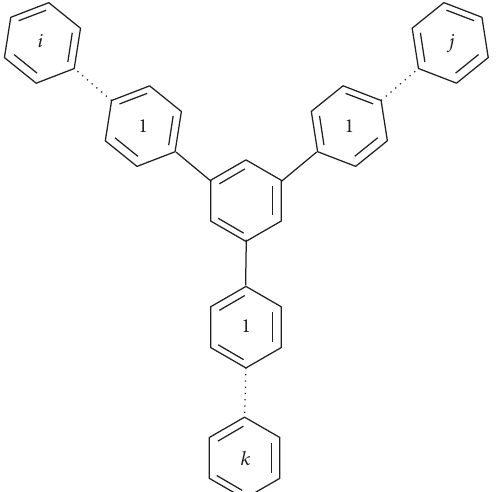
Figure 1: 𝐿 -type polyphenyl